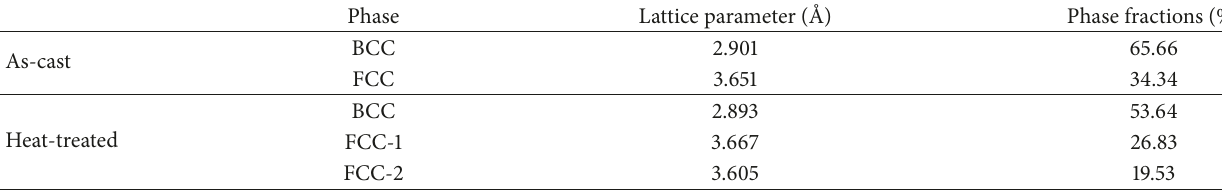
Table 1: Rietveld Refinement results of the as-cast and heat-treated sample.